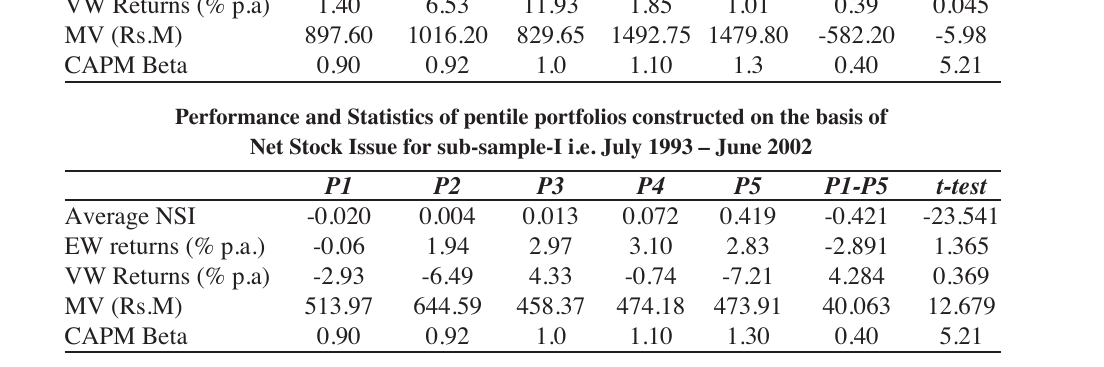
Performance and Statistics of pentile portfolios constructed on the basis